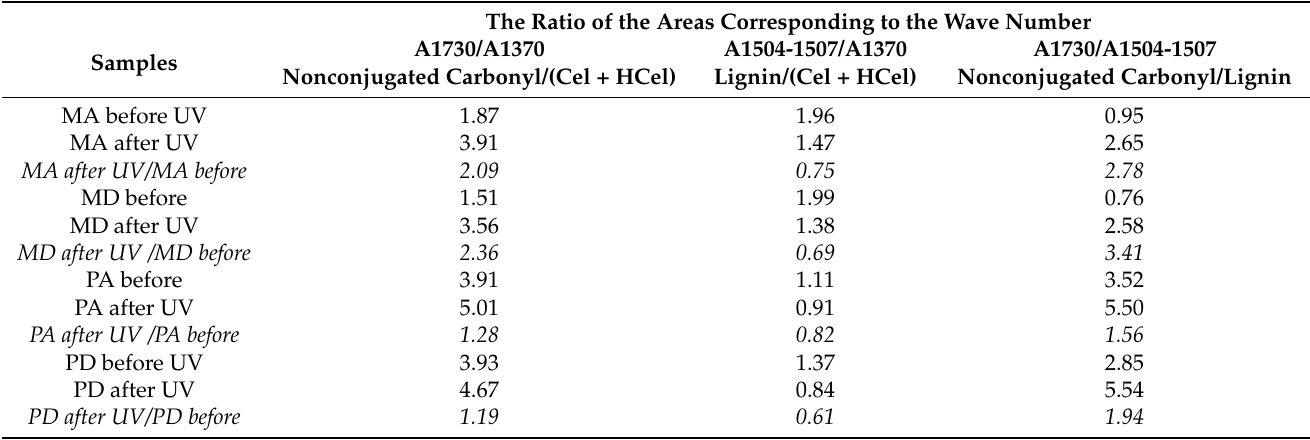
Figure 13. Comparative FTIR spectra for spruce wood and sycamore maple wood samples for the narrow range of 1800–600 cm − 1 encompassing the fingerprint region. Table 3. Chemical differences between spruce and sycamore maple wood before UV